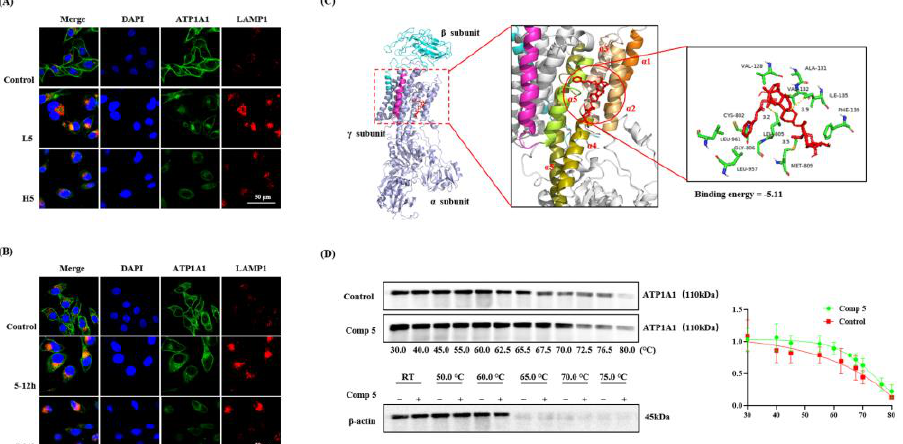
Figure 4. Compound 5 promoted the endocytosis and degradation of ATP1A1. ( A ) HepG2 cells were treated with 12.5 μmol∙L −1 or 25 μmol∙L −1 5 for 48 h, and the lysosomal co-localization assay was performed with a confocal laser. ( B ) Cells exposed to 25 μmol∙L −1 5 for 12 h or 24 h were detected by fluorescence staining. ( C ) 5 is depicted in red, and the chains of Na + , K + -ATPase α/β/γ are represented by light blue, cyan-blue, and magenta, respectively. The crystallography, atomic coordinates, and structure factors have been deposited in the Protein Data Bank, www.pdb.org (PDB ID code 3KDP). ( D ) The CETSA binding assay of ATP1A1 and β-actin in the presence or absence of 5 (50 μmoL −1 ) at different temperatures was detected by western blot. The temperature-dependent melting curves and the apparent aggregation temperature were calculated by nonlinear regression. Values represent the mean ± SEM (N = 3 replicates).